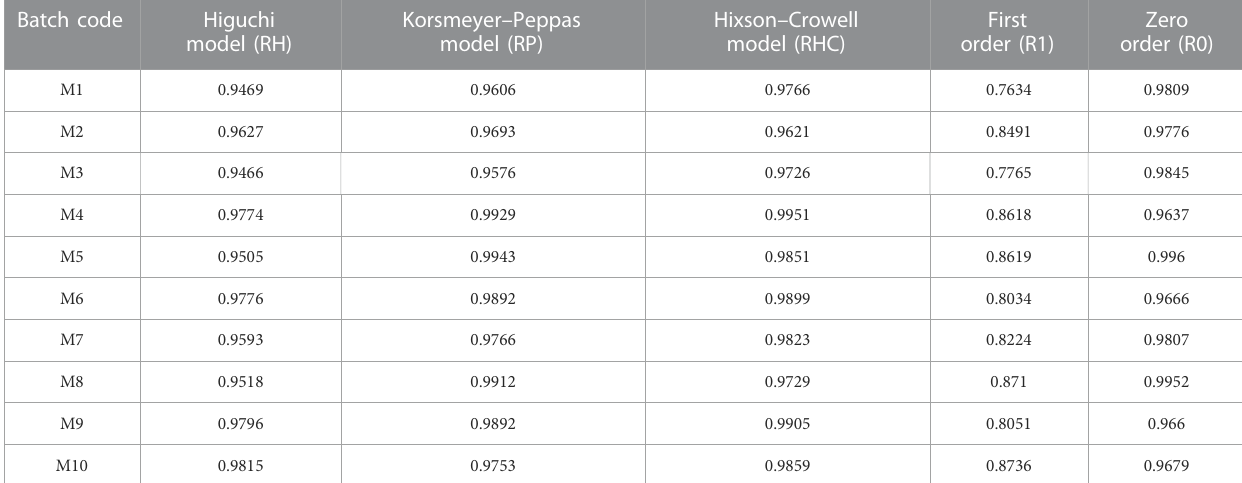
Batch code Higuchi model